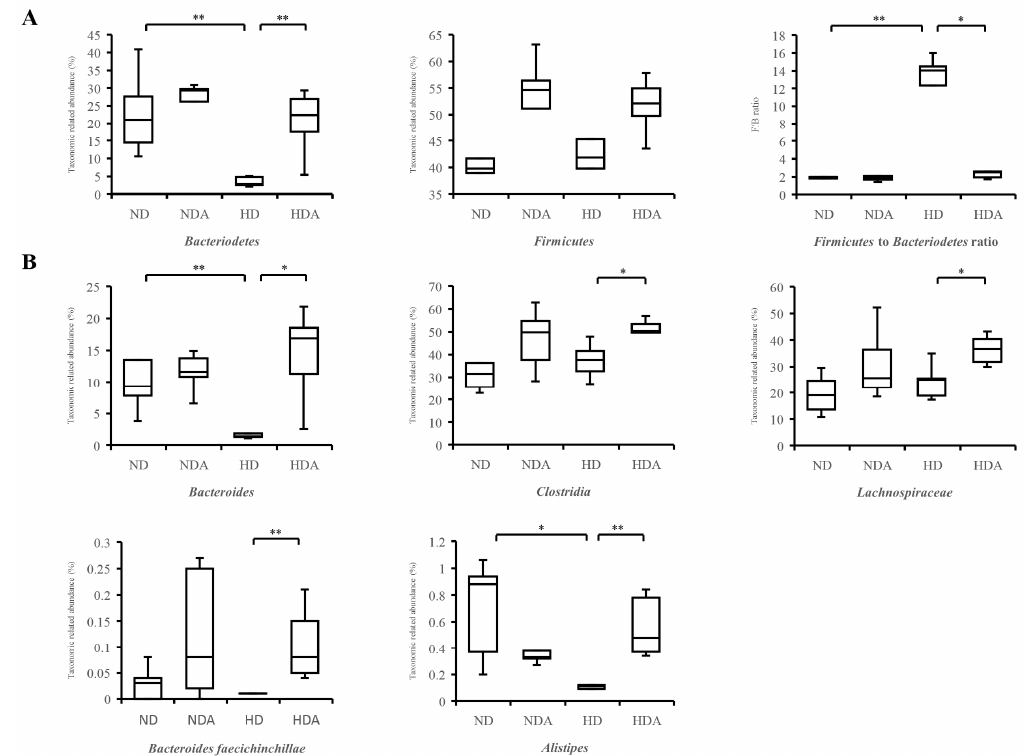
Figure 5. The relative abundance of specific bacteria in the cecum. ( A ) Bacteroidetes, Firmicutes, and Firmicutes to Bacteroidetes ratio. ( B ) Specific bacteria of important taxa in the human gut. The nonparametric Wilcoxon signed rank test for paired data and Mann–Whitney U test for unpaired data were used. Significant differences are indicated as * p < 0.05, ** p < 0.01.